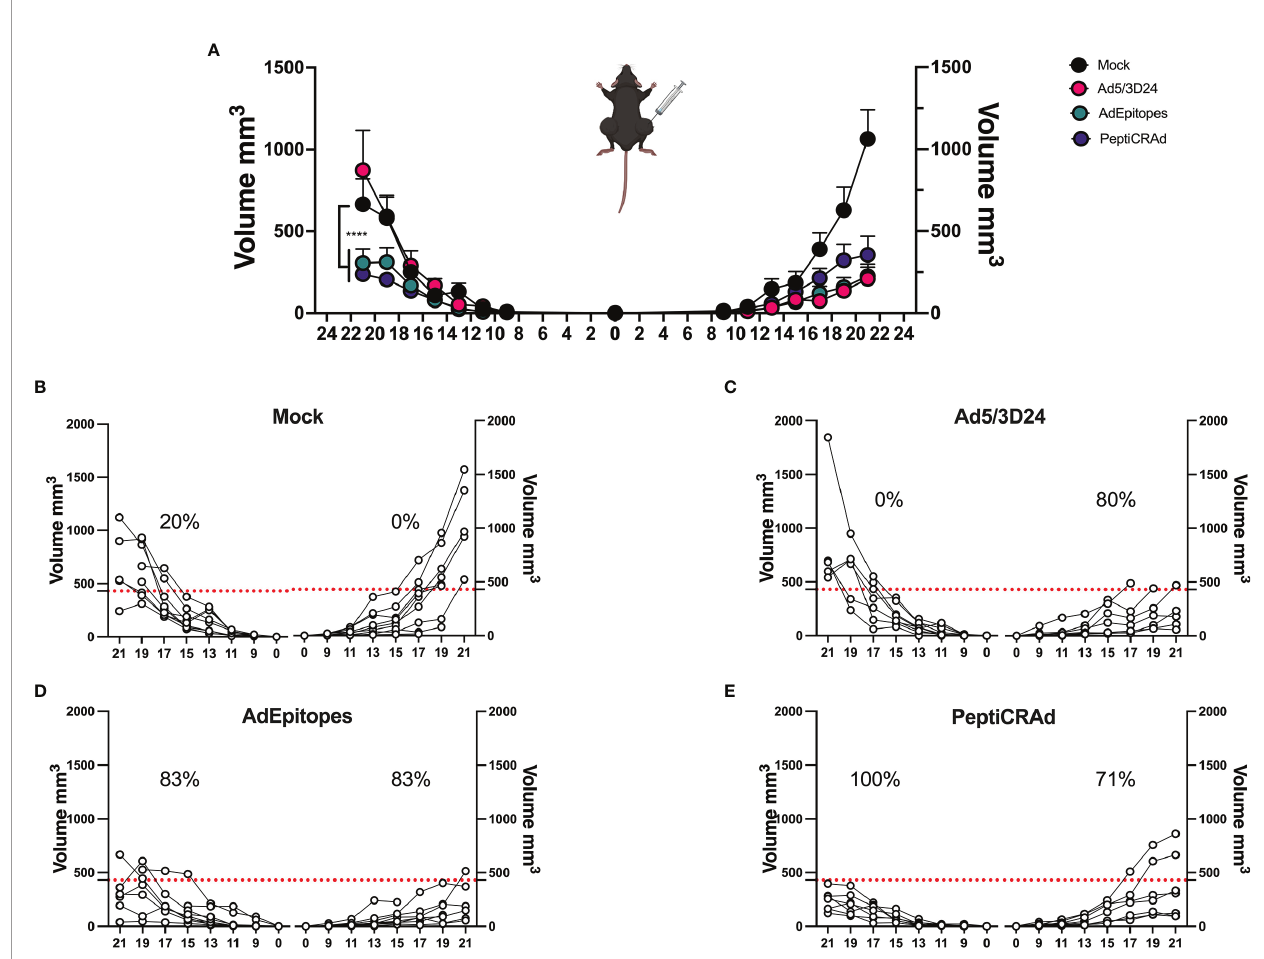
FIGURE 6 | PeptiCRAd elicited local and systemic antitumor response in a poor immunogenic tumor melanoma model. (A) Immunocompetent C57Bl/6 mice were subcutaneously injected with the syngeneic tumor model B16.F1 in the left (0.5x10 4 cells) and right fl ank (1x10 5 ). Ad5/3 D 24, AdEpitopes and PeptiCRAd were intratumorally administrated four times, two days apart starting from day 9. The B16F1 tumor growth was followed until the end of the experiment and the tumor size is presented as the mean ± SEM and statistically difference was assessed with two-way ANOVA; (ns P > 0.05, *P ≤ 0.05, **P ≤ 0.01, ***P ≤ 0.001, ****P ≤ 0.0001). (B – E) Single tumor growth for single mouse for Mock (B) , Ad5/3 D 24 (C) , AdEpitopes (D) and PeptiCRAd (E) is shown. A threshold of 431 mm 3 was set to de fi ne the percentage of mice responding to the different therapies (red dotted line) for right and left tumors. The percentage of responders in each treatment group is shown on the top of the dotted line. The threshold was de fi ned as the median of the tumor size at the last day of the experiment in Ad5/3 D 24 treated group. (Mock n=9, Ad5/3 D 24n=9, AdEpitopes n= 9, PeptiCRAd